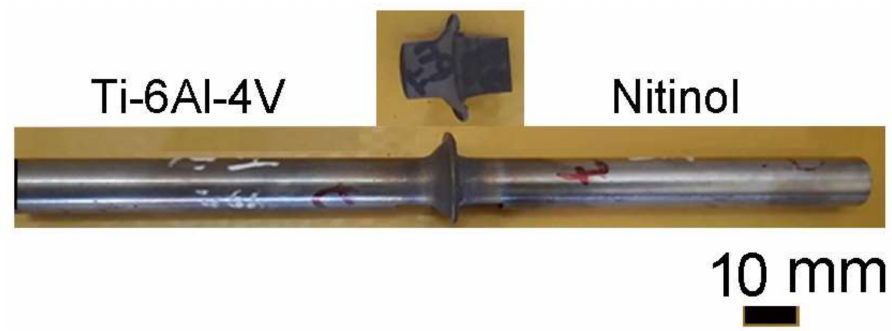
Figure 3. The visual view of a Ti-6Al-4V and Nitinol dissimilar friction welded joint.